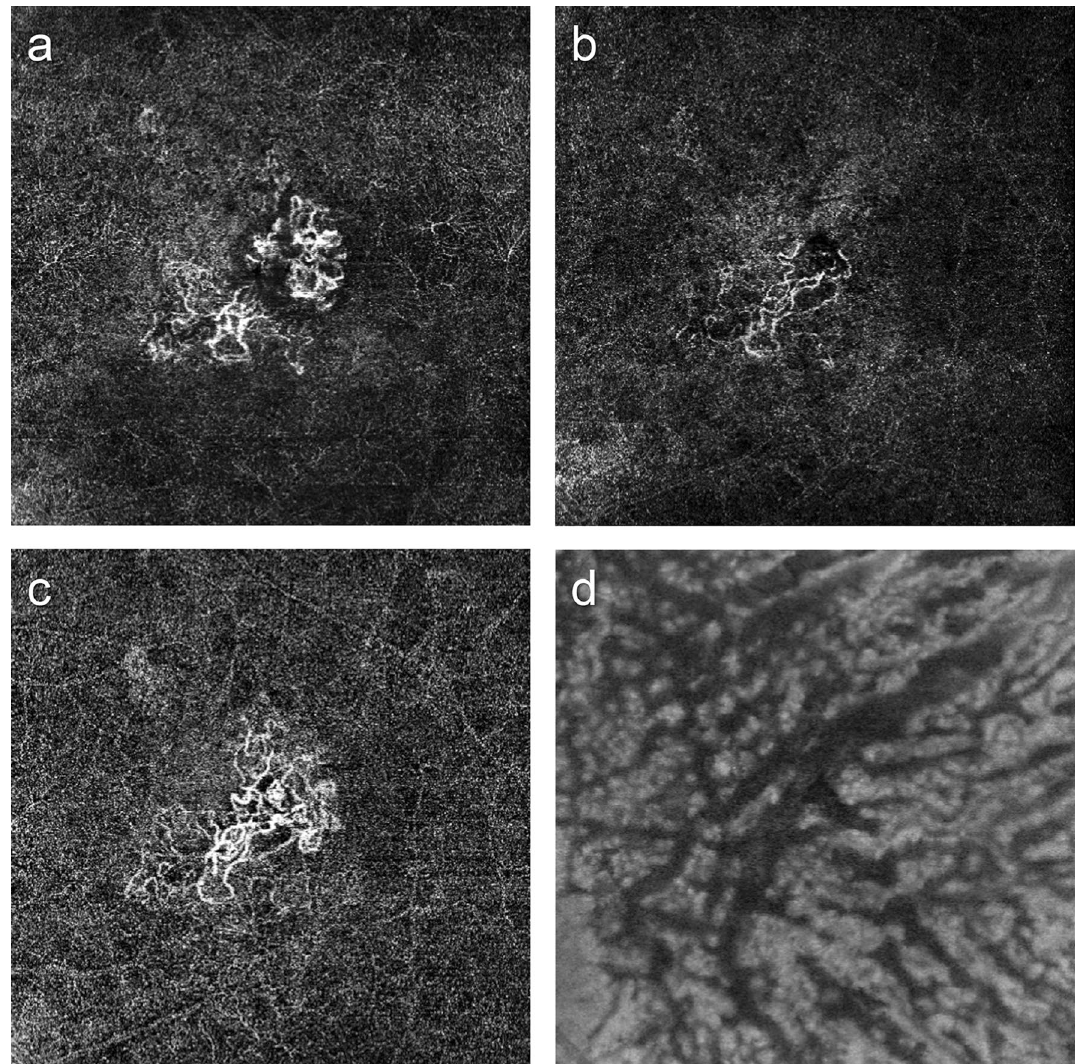
Figure 2. Changes in macular neovascularization (MNV) and Haller vessel morphology in eyes with visual acuity gain and infrequent injections. ( a ) Initial optical coherence tomography angiography image of a patient before the first injection shows MNV with well-developed peripheral anastomoses. The best-corrected visual acuity was 20/200 at the initial visit and 20/25 after 1 year. The total number of injections was 4. The vessel area was 1.1 mm 2 , while the mean and maximal vessel diameters were 22.2 and 65.5 μm, respectively. ( b ) After three loading injections, the vessel diameter decreased, as did the MNV size. The vessel area was 0.7 mm 2 , while the mean and maximal vessel diameters were 19.3 and 52.4 μm, respectively. ( c ) After 1 year, MNV and its diameter increased, but the overall morphology was not remarkably different from that of the initial MNV. The vessel area was 1.3 mm 2 , and the mean and maximal vessel diameters were 20.4 and 91.7 μm, respectively. ( d ) En